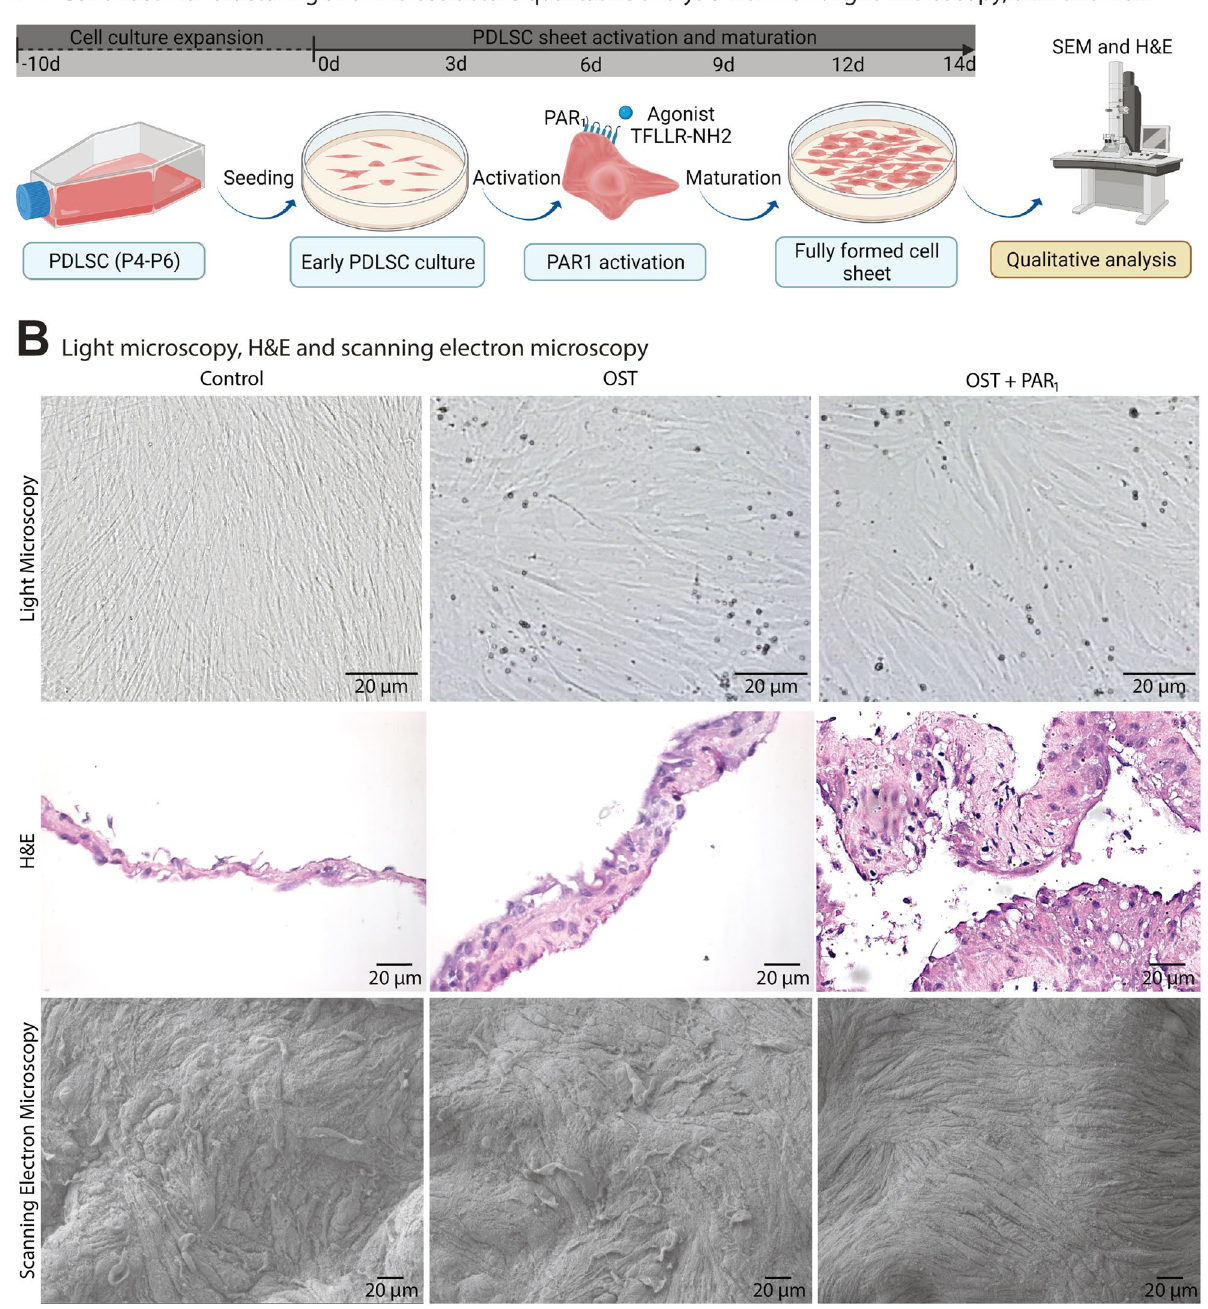
Figure 2. ( A ) Cell sheets manufacturing and macroscopic morphological characterization workflow. ( B ) Light microscopy (40x), cell sheet histological profile by H&E staining and microstructural analysis through scanning electron microscopy (400x) from cell sheets for the 3 experimental